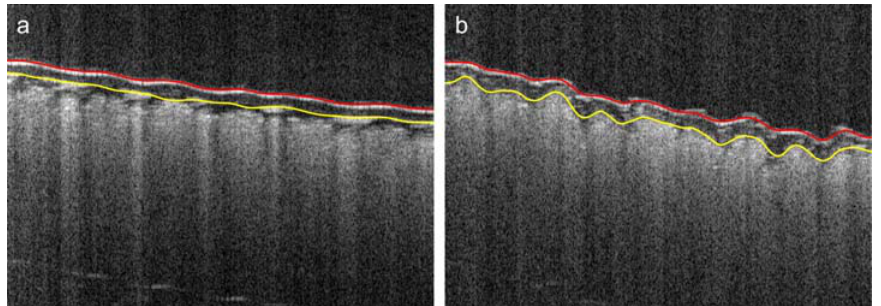
Figure 15. Example Cordura B ‐ scans for two types of polymer layer: ( a ) Cordura 1 (yellow) with detectable internal boundary of the laminated polymer layer; ( b ) Cordura 3 (true navy) with polymeric internal boundary adhering to the fabric layer.